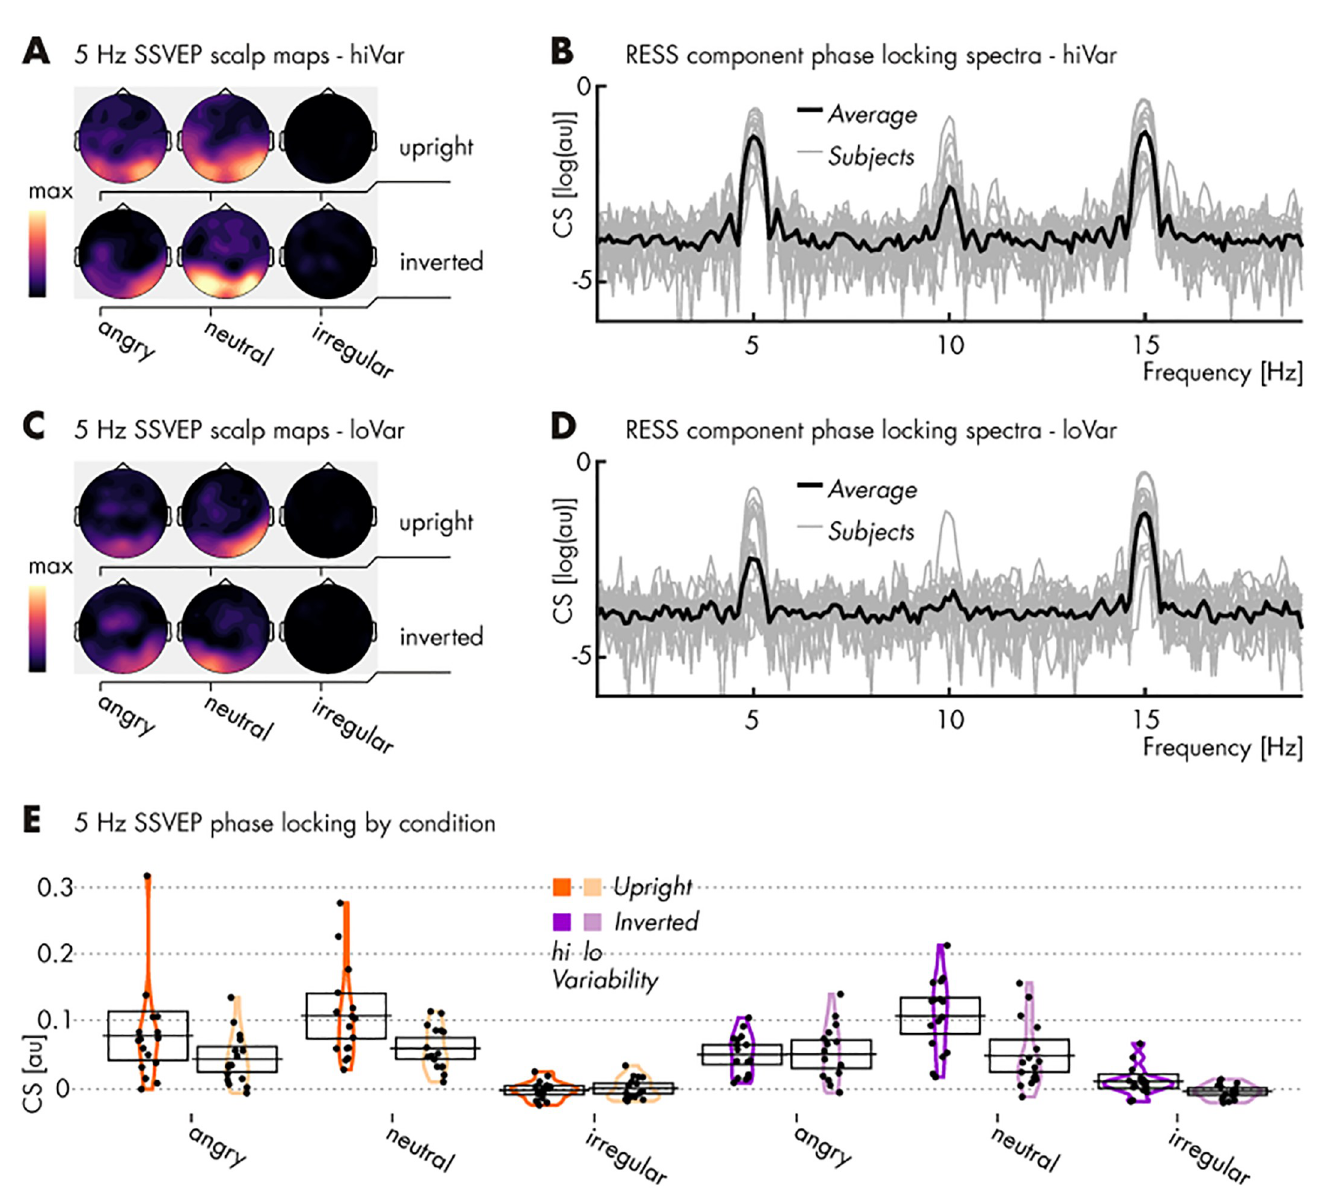
Fig 4. Spectral characteristics of EEG responses to stimulation in Pilot 2 . ( A ) Topographical distributions of phase-locking, quantified as cosine similarity (CS), at the regularity frequency of 5 Hz for high variance stimuli. Note the lack of phase-locking, i.e. consistent responses to the irregular stimulation conditions (maps same scale, in arbitrary units); ( B ) CS index of phase locking across the EEG spectrum (arbitrary scale) with the group average superimposed on single subject spectra, based on RESS spatial filter projections and collapsed across conditions featuring a regular presentation of high variance stimuli (i.e., excluding irregular stimulation conditions for their lack of signal; see A ). For visualization only, CS has been converted to log(CS); ( C & D ) Same as in panels A & B (identical scale) but for 5 Hz SSVEPs driven by low variance stimulation; ( E ) CS at the regularity frequency for each participant (single dots) and condition. Mean values are marked by horizontal black lines and 95% confidence intervals represented as transparent boxes. See Table 3 for specific results of statistical